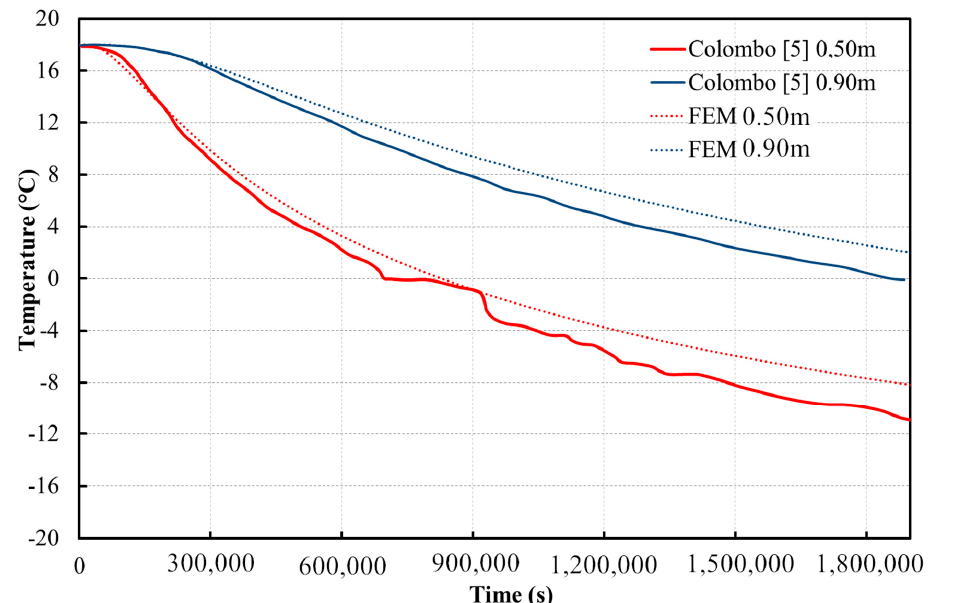
Figure 1. Mesh and development of the frozen wall for model validation.